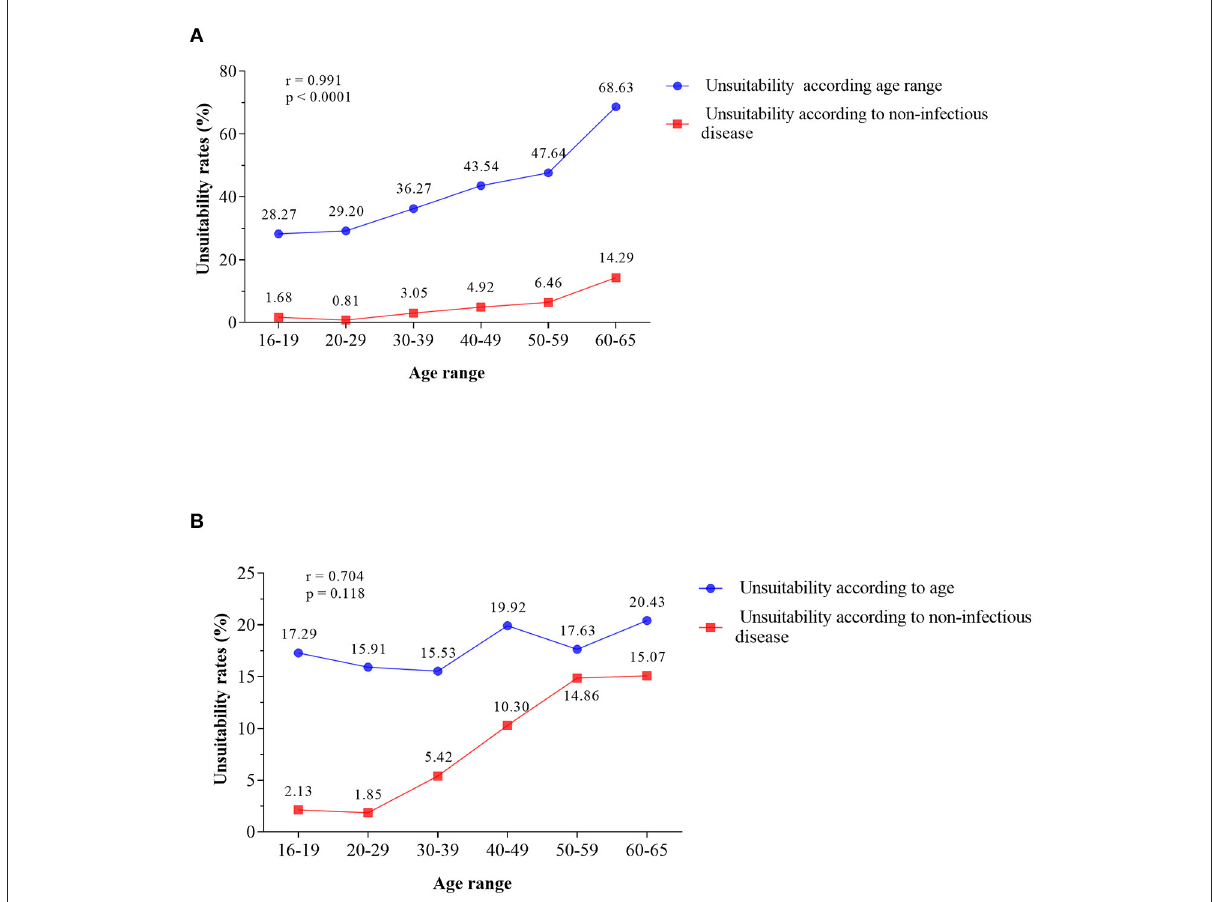
FIGURE3 Positive correlation between the increase in donor age and the percentage of unsuitability due to chronic non-infectious diseases. (A) First donation and return visit. (B) Pearson’s